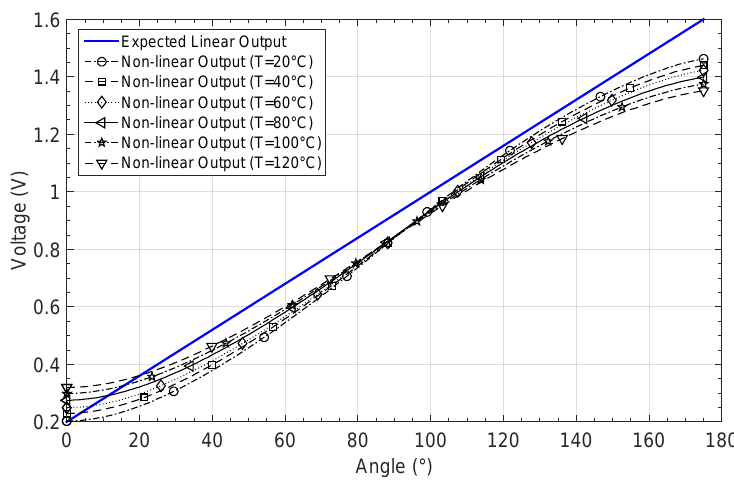
Figure 23. Non-linear giant magneto-resistance (GMR) response by considering different temperatures.